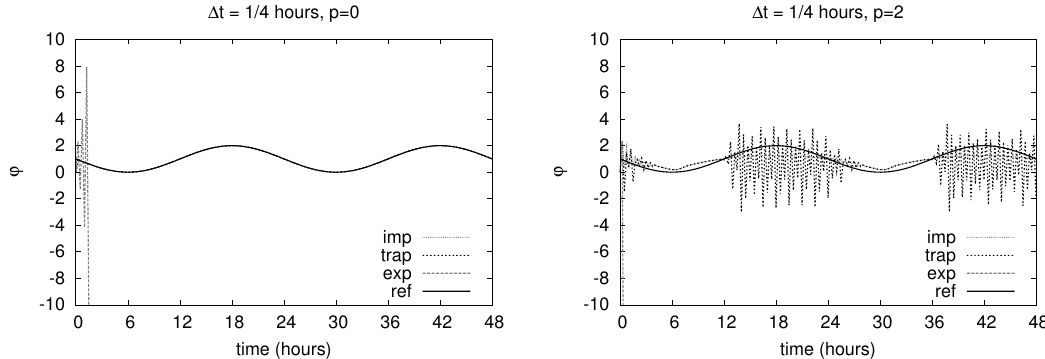
Fig. 2. The left figure shows the referent numerical solution of Eq. (1) (using scheme described by Eq. 2) for the linear problem with p = 0.